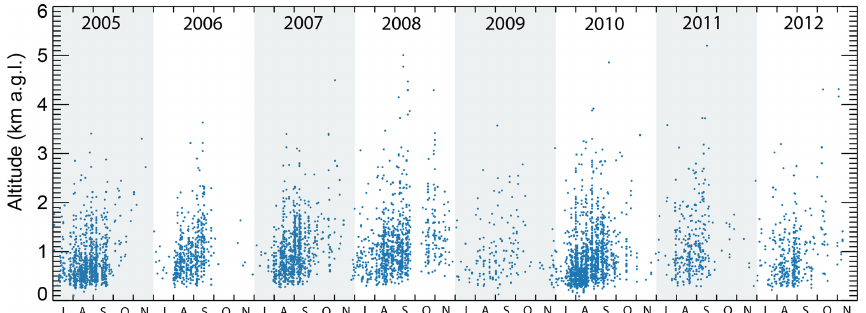
Figure 3. Time series of the 2005–2012 MISR Amazon smoke-plume-height climatology, covering the July–November burning season for each year. Each blue dot represents the maximum smoke height above ground level (agl) for one plume.